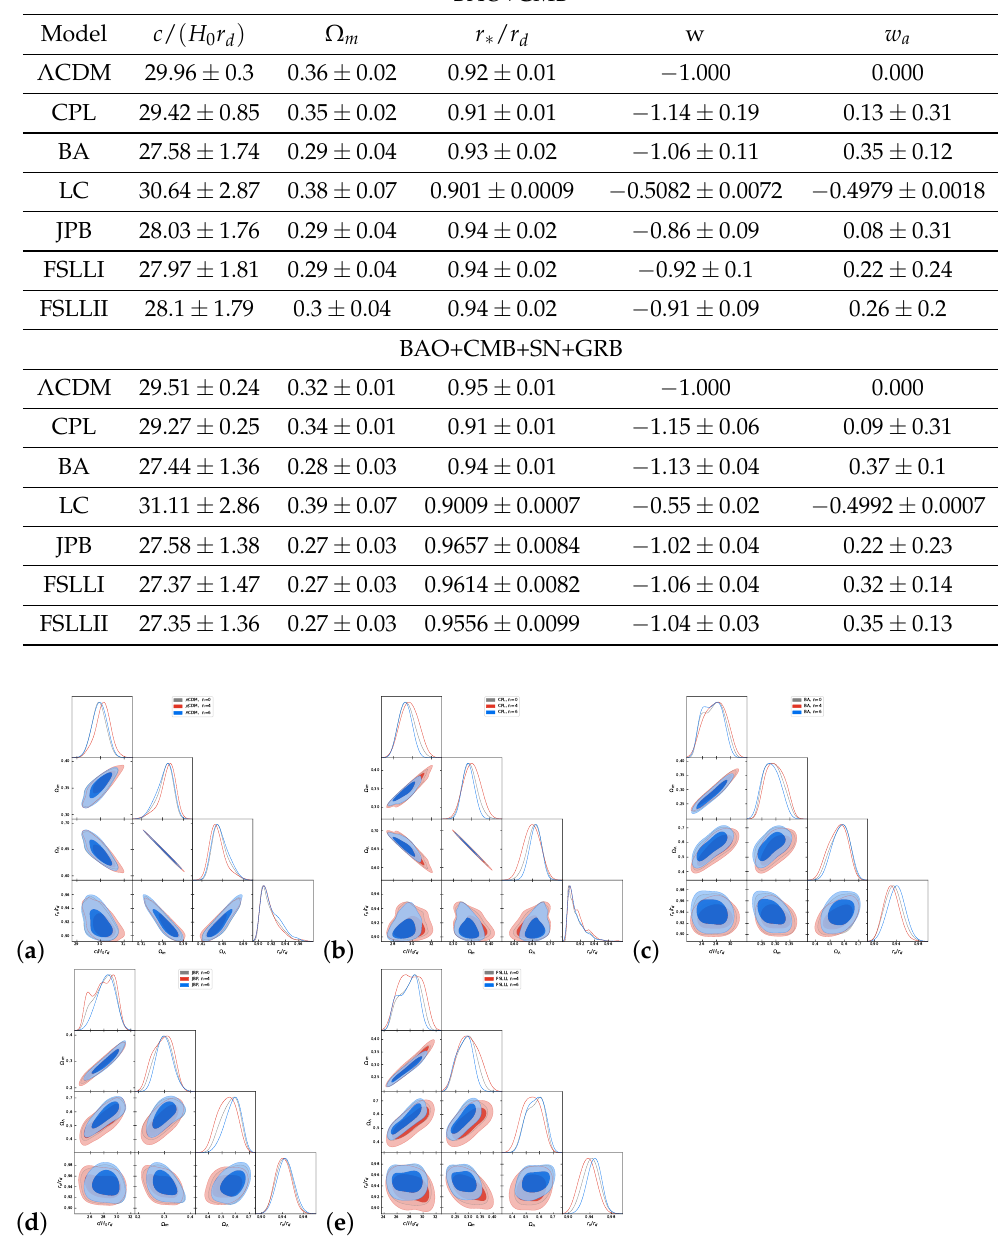
Figure A1. The covariance test plot for the considered models: ( a ) Λ CDM, ( b ) CPL , ( c ) BA , ( d ) JPB , ( e ) FSLLI